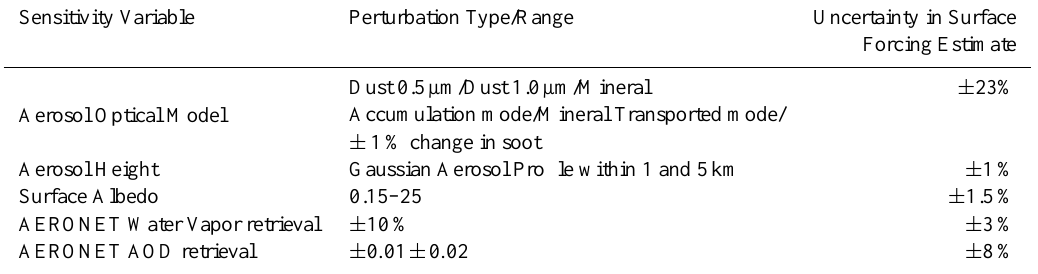
Table 3. Uncertainty in radiative effect at surface from RTM calculations based on perturbations of several sensitivity variables including aerosol optical mode, aerosol height, broadband surface albedo and AERONET water vapor and AOD measurement uncertainties.